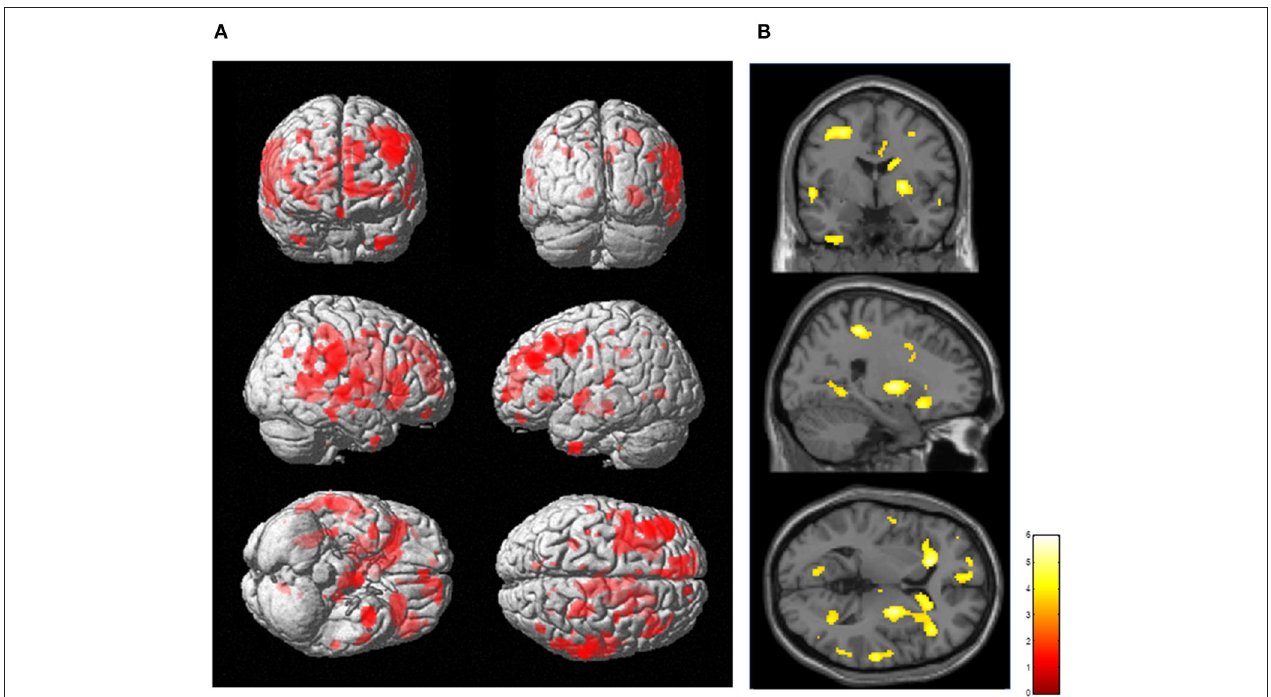
FIGURE 1 | Reduced cerebral [ 11 C]FMZ BP ND in the Parkinson’s disease group relative to the control group. The statistical threshold was set at P < 0.001, uncorrected multiple comparisons. (A) Results are shown on a three-dimensional rendering of the brain surface. Color bar represents the T value. The patient group showed significant cerebral reduction of [ 11 C]FMZ BP ND predominantly in the bilateral frontal and temporal cortex (shown in red). (B) Results are shown on canonical T1 images. The patient group showed a significant reduction in [ 11 C]FMZ BP ND on the more affected side of the basal ganglia (shown in